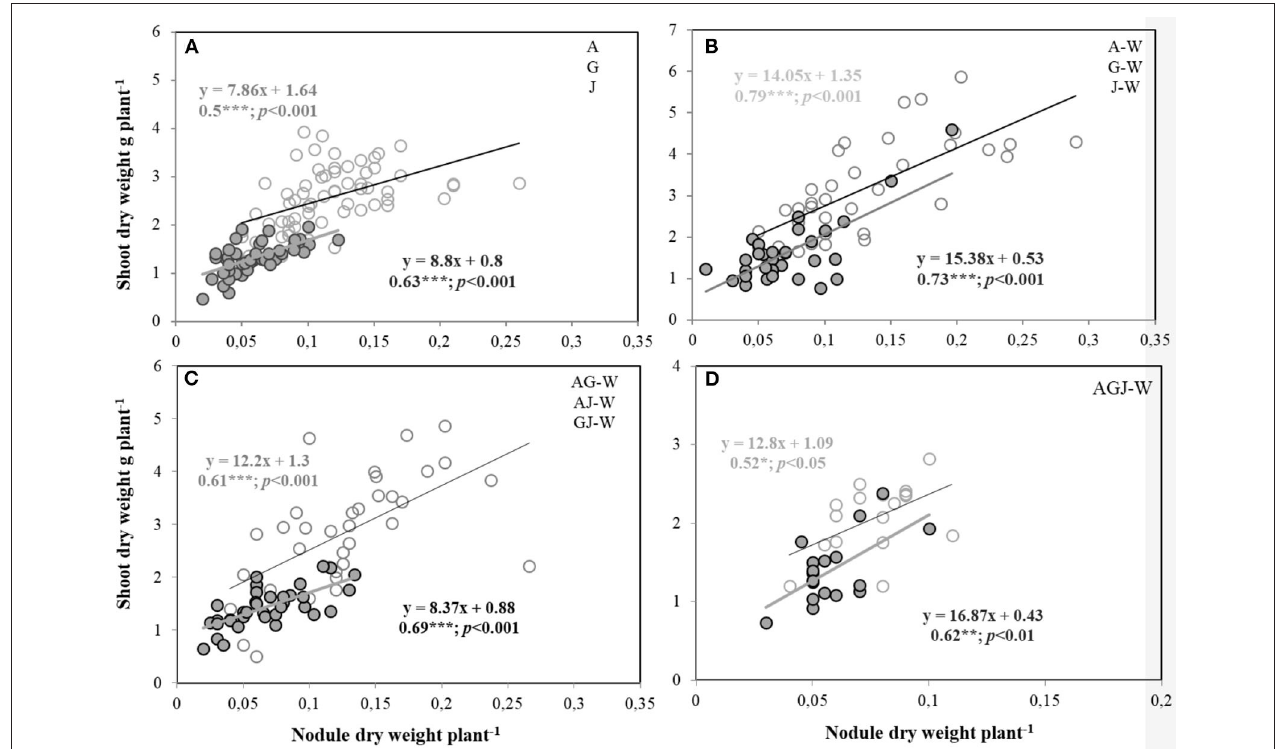
FIGURE 4 | Efficiency in the use of the rhizobial symbiosis (EURS) for growth of the three faba bean varieties, A, G, and J and W, grown as sole crops [A, G, and J in (A) ] or intercropped with W in three different levels: wheat intercropped with a single faba bean variety [ (B) WA, WG, and WJ], wheat intercropped with two different faba bean varieties [ (C) WAG, WAJ, and WGJ], and wheat intercropped with three different faba bean varieties [WAGJ in (D) ]. Plants were grown under water sufficiency (80% field capacity; open circles) vs. water limitation (30% field capacity; filled circles). Asterisks *, **, and *** denote significant difference at p < 0.05, p < 0.01, and p <